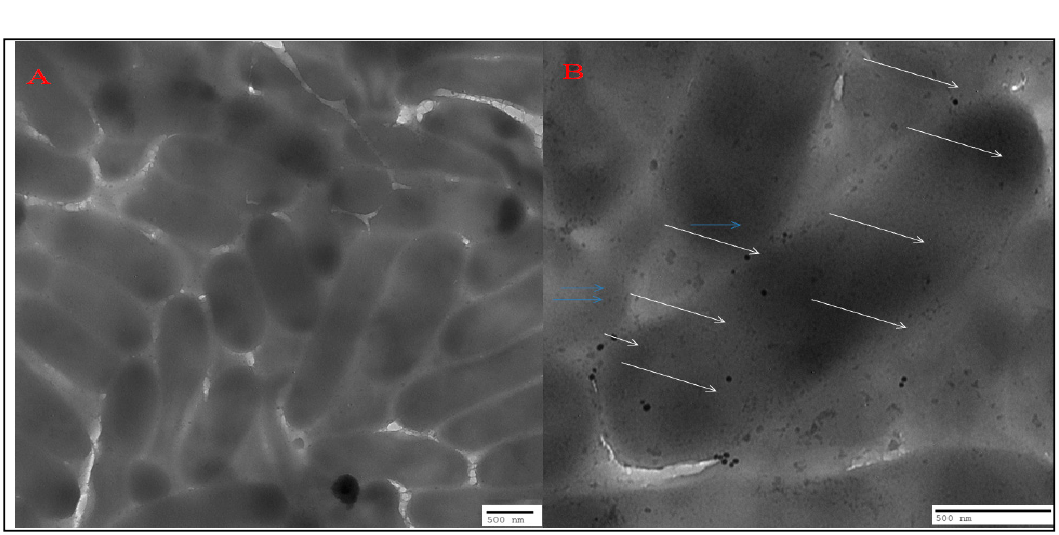
Figure 7. Ultrastructural changes caused by gold nanoparticles as analyzed by TEM. ( A ) Images of the control setup of P. aeruginosa PAO1 without treatment with nanoparticles. ( B ) Images of the experimental setup of PAO1 treated with 150 µg/mL of AuNPs. Blue arrows indicate nanoparticles outside the cell, whereas white arrows indicate internalized nanoparticles.